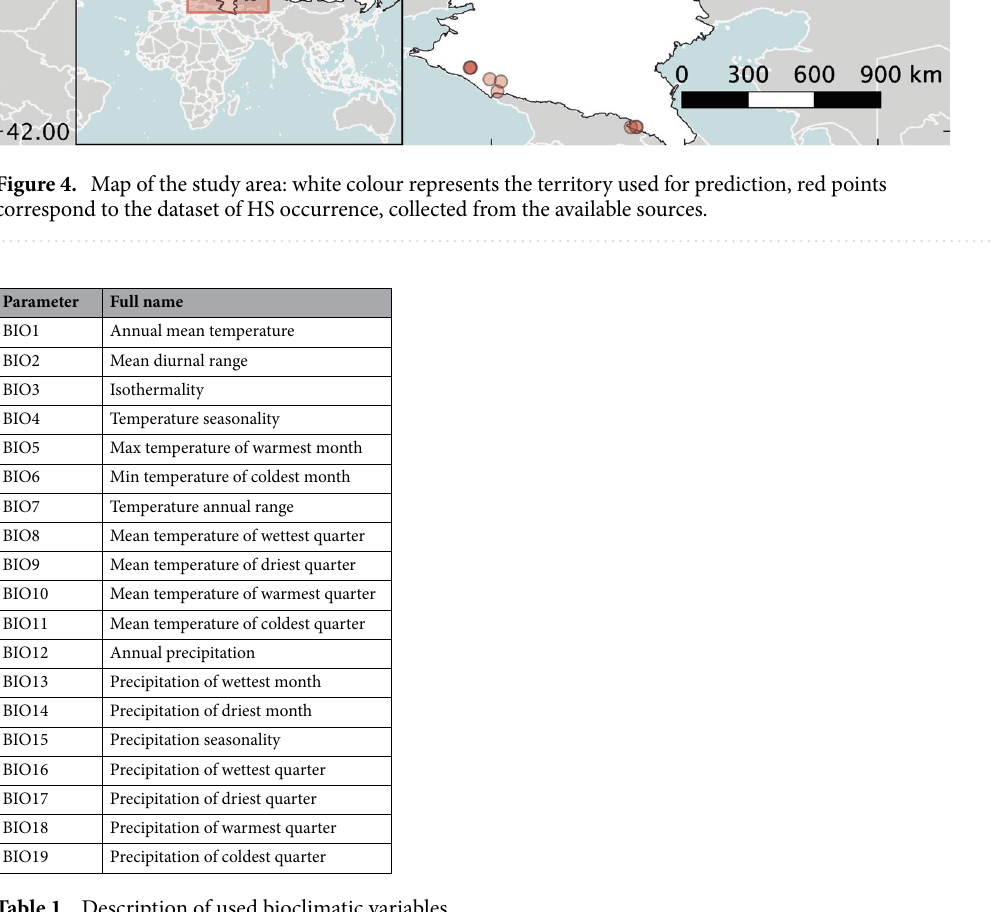
Table 1. Description of used bioclimatic